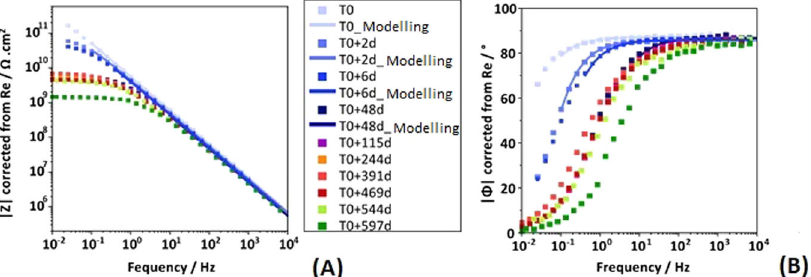
Fig. 4 Bode diagrams obtained regularly during 597 days of painted DH36 steel immersed in seawater. The modulus in ( A ) and phase in ( B ) are plotted as a function of frequency, in arti fi cial seawater at 20 °C, under natural aeration and static